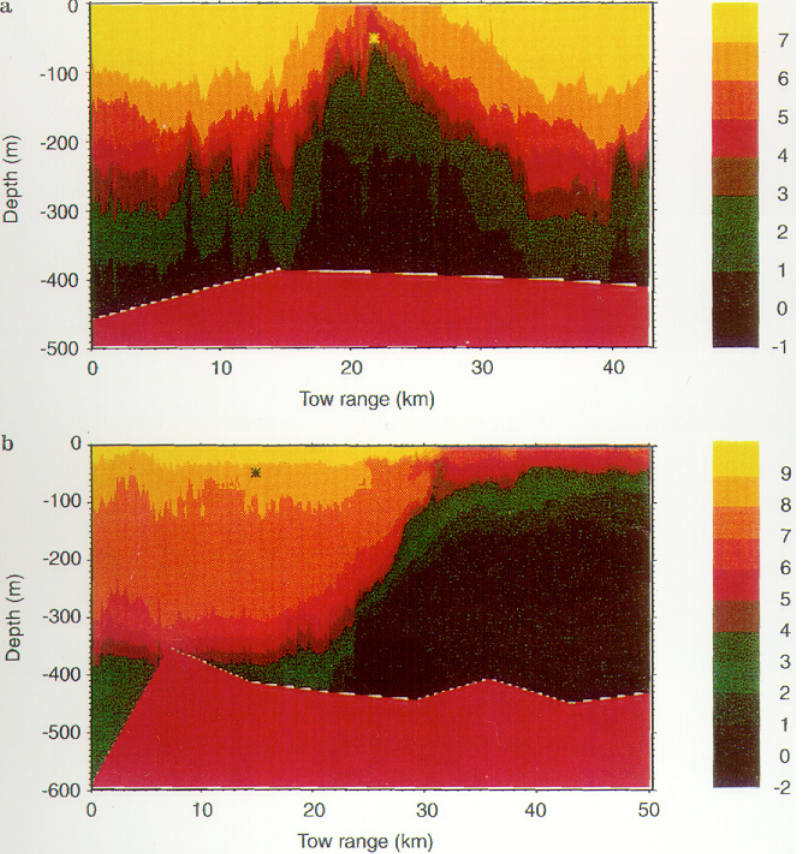
Fig. 7a, b. Temperature cross-sections down to the seabed for the two environments: a the cold eddy and b the front. The temperature scale in ° C is shown on the colour - bar . The position of the acoustic source used for the acoustic computations is marked by a yellow asterisk in a and a black asterisk in